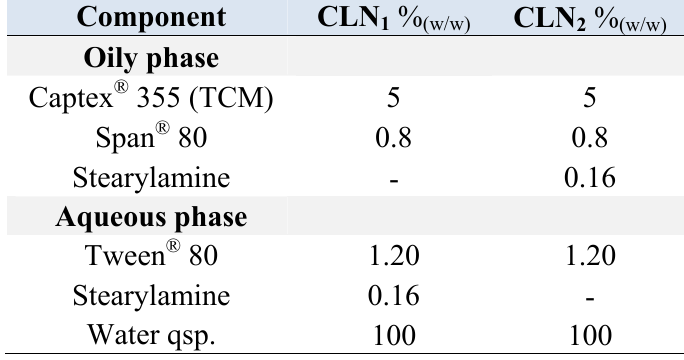
Table 1. Composition of the CLNs: CLN with stearylamine dispersed into aqueous phase ) or CLN with stearylamine dispersed into oily phase (CLN (CLN 1